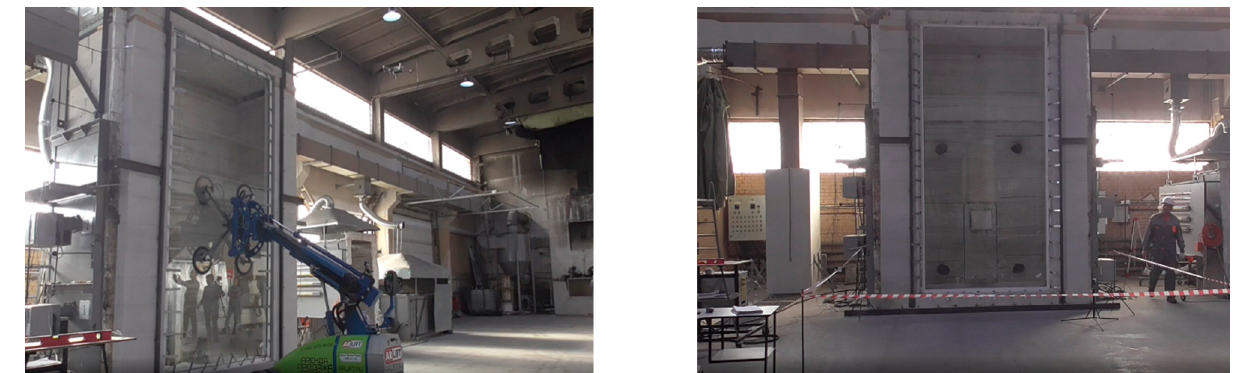
Figure 4. Installation of a monolithic single-layer glass panel in the furnace opening. Photo by the